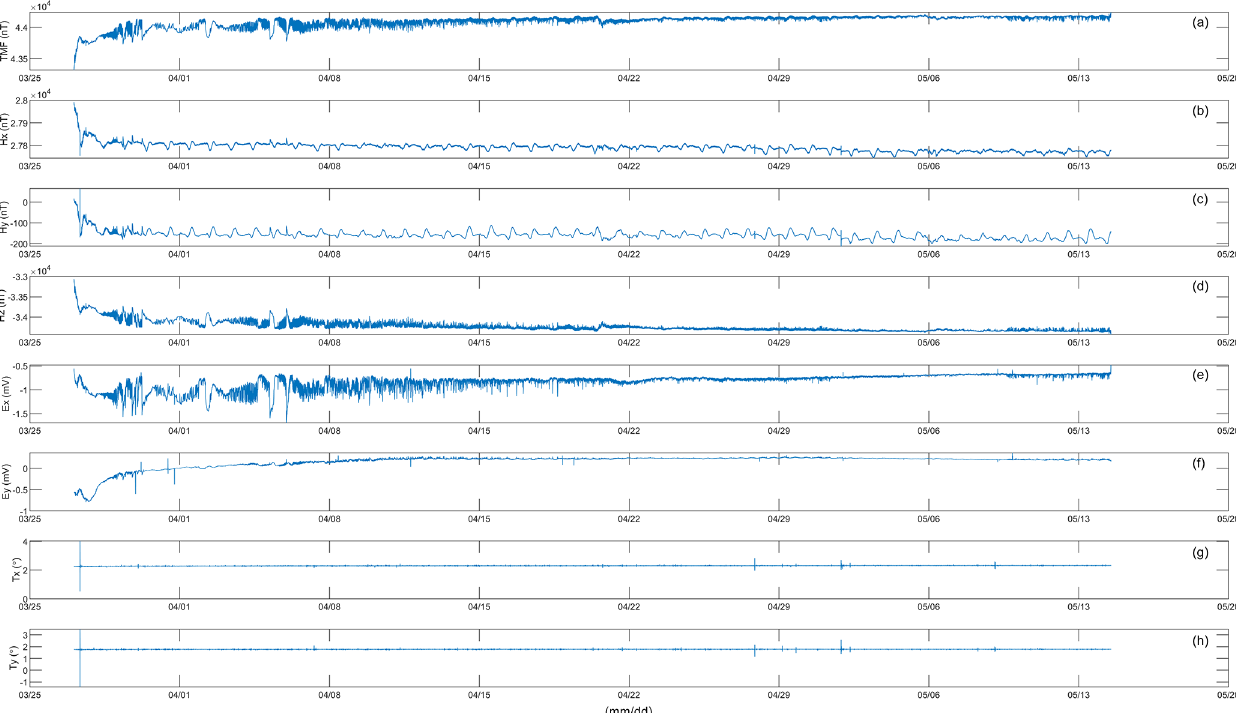
Figure 12. The OBEM01 time series data. The panels from top to bottom in the figure show the four magnetic fields ( a–d : TMF, HX, HY and HZ), the two electric fields ( e, f : EX and EY) and the two inclinations ( g, h : TX and